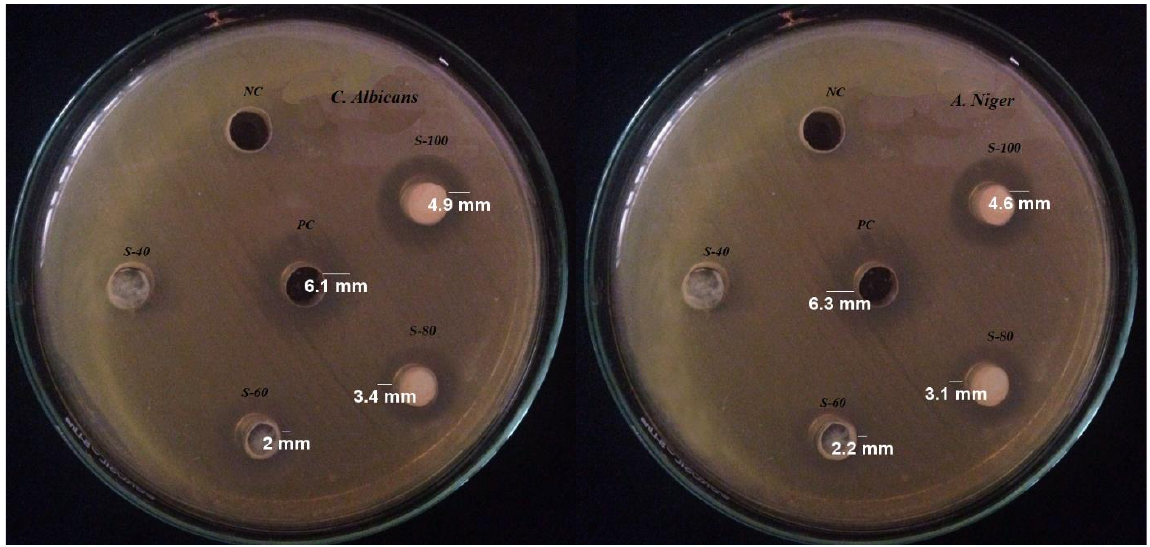
Figure 8. Experimental photographs of antifungal activity of SnO 2 NPs against selected fungi at different concentrations. Table 1. Antifungal activity of SnO 2 NPs against the selected fungi and statistical analysis.